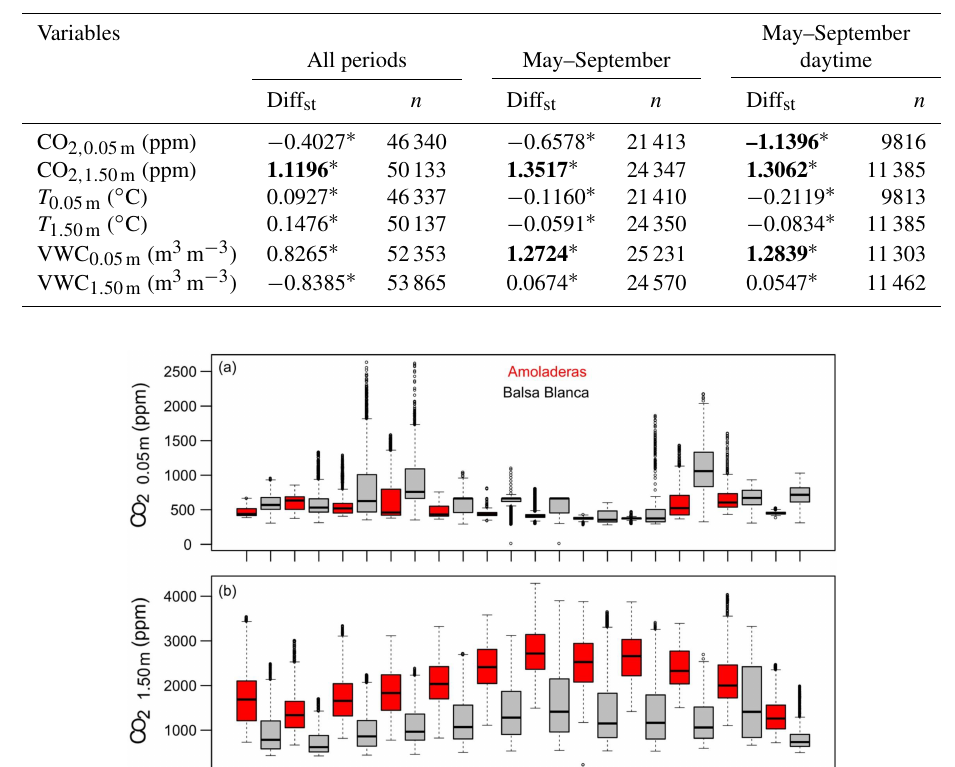
Table 6. Results of the two-sided Wilcoxon summed rank test used to assess differences among soil variables measured at each experimental site over all periods, from May to September and from May to September during daytime, separately. Medians of the difference between the samples (Amoladeras minus Balsa Blanca) in standardized terms (Diff st ) and number of observations are detailed. Significant results ( p -value < 0.05) are denoted with asterisks, and bold values represent those variables with Diff st between sites above 1.